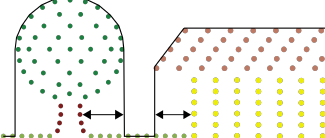
Figure 5. The black arrows show the discrepancy between the 2.5D mesh ( black line ) and the colored 3D point cloud for a tree ( left ) and a building ( right)